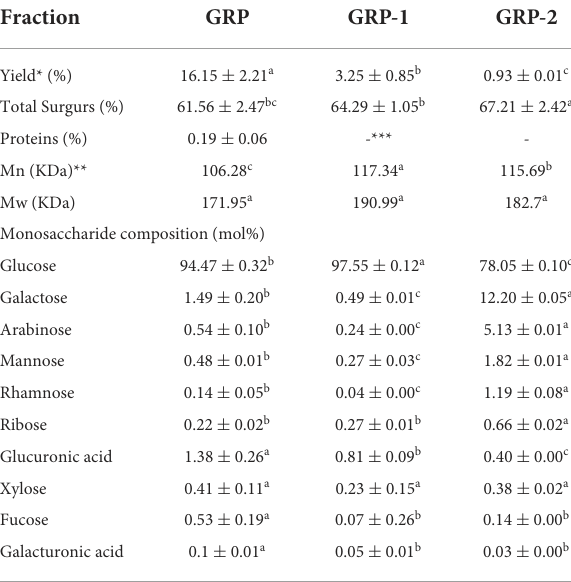
TABLE 1 Physicochemical properties of the polysaccharides isolated from ginseng